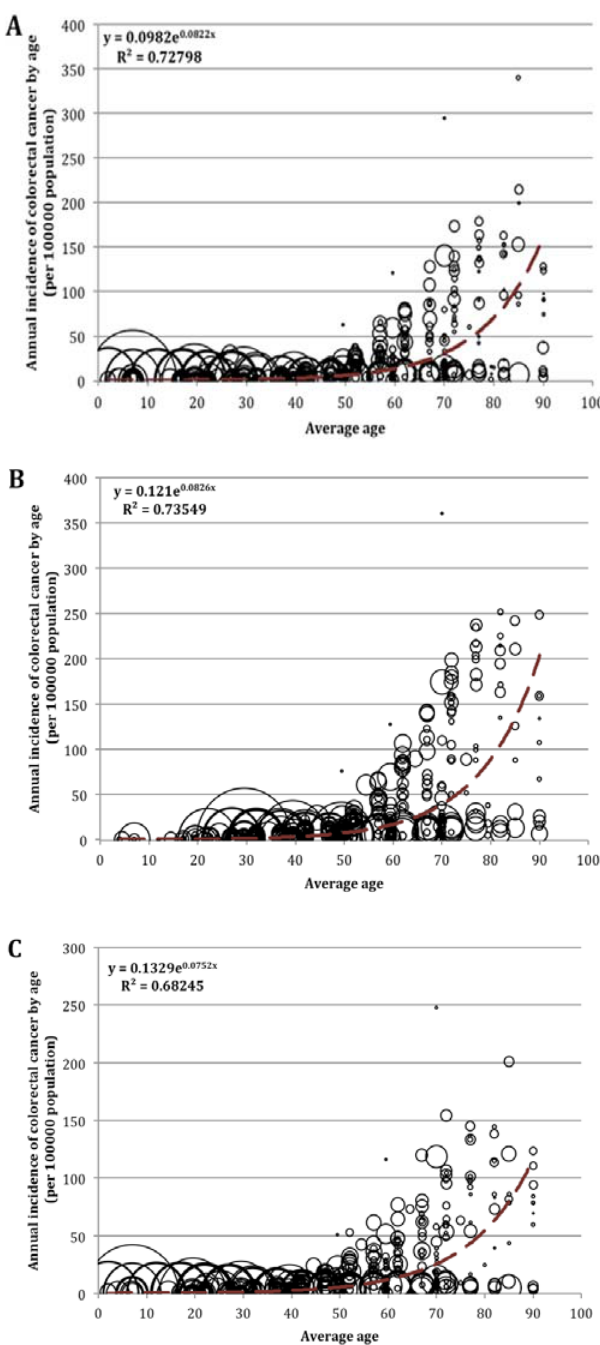
Figure 6 Incidence of colorectal cancer by age groups for both sexes ( A ), men ( B ) and women ( C ).